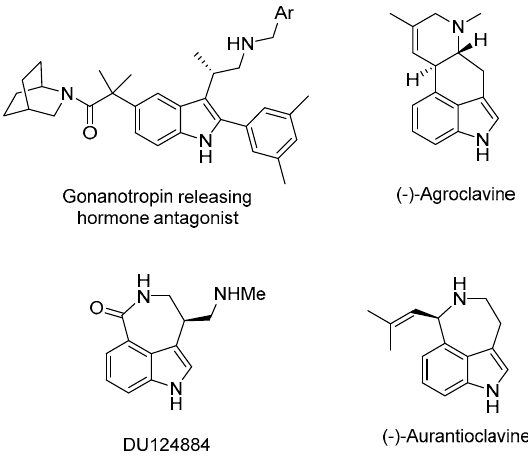
Figure 1. Selected natural products containing the indole moieties.